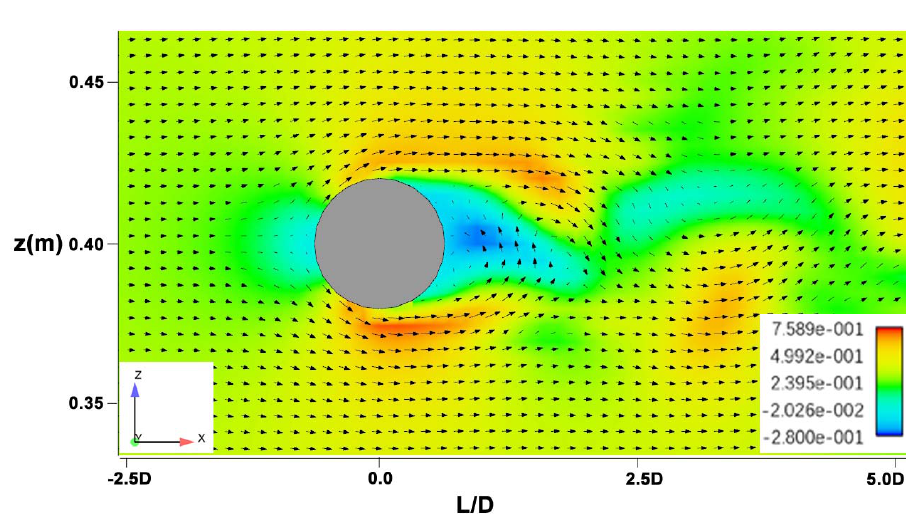
Figure 7. The velocity field around the cylinder on the bed.